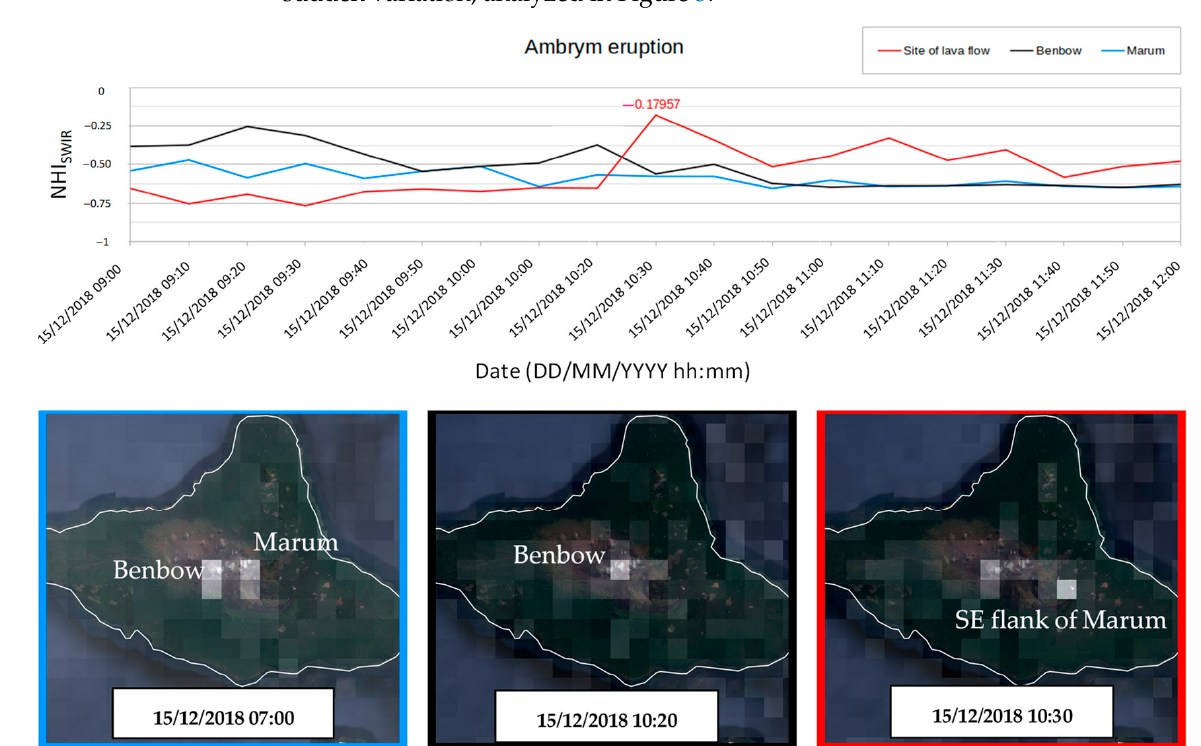
Figure 3. Time series of the NHI SWIR index retrieved, at 10 min time interval, over the Benbow (black line) and Marum (blue line) crater, and the area affected by intra-caldera eruption (red curve), from Himawari-8 AHI data of 15 December 2018 at 09:00 − 12:00 LT. On the bottom, NHI SWIR image overlapped on the map of Ambrym volcano; light grey pixels indicate higher values of the used index. The dotted black lines indicate the time interval associated with the start of the lava effusion.